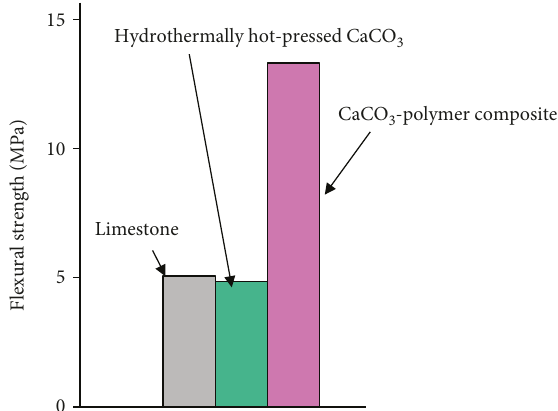
– polymer nanocomposite 3 produced 3